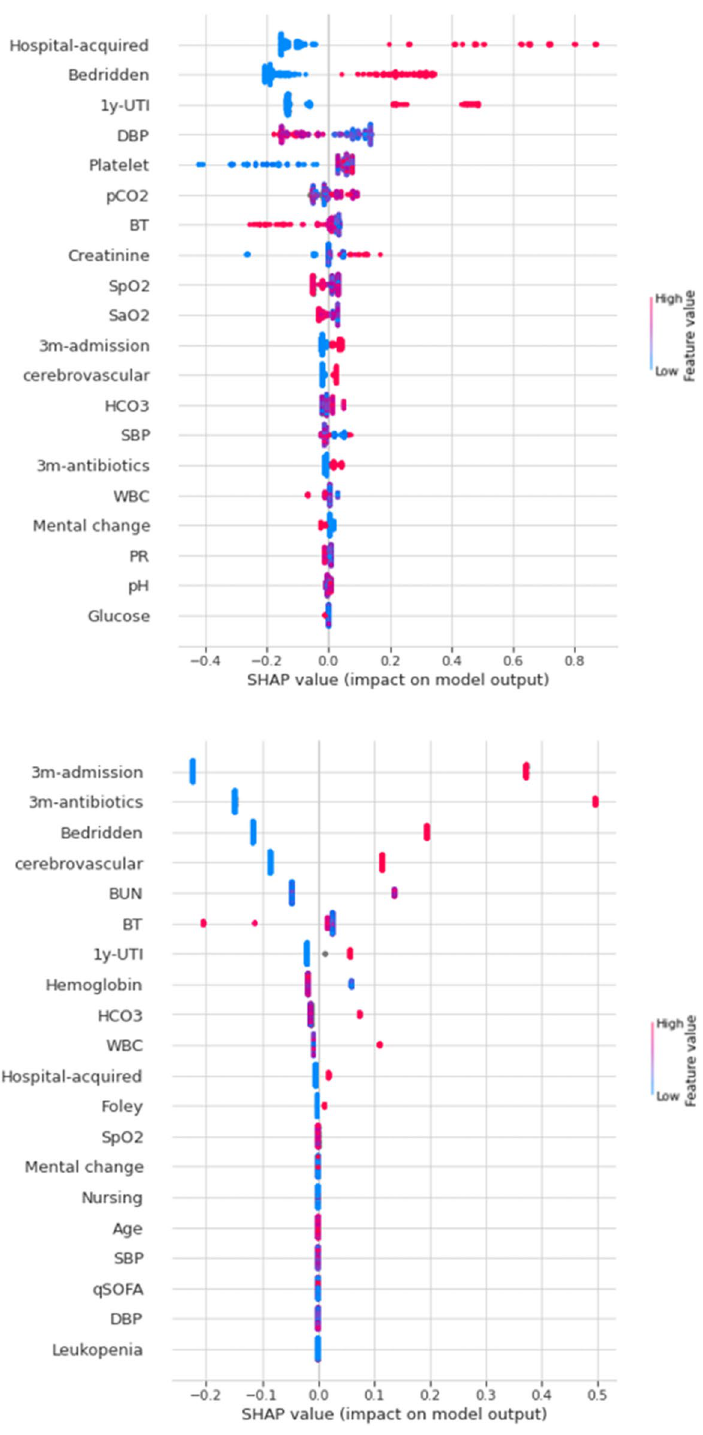
Figure 5. Feature importance for ciprofloxacin resistance (top) and positivity of extended-spectrum beta- lactamases (bottom) using Shapely Additive exPlanations (SHAP). The top 20 variables were visualized among 39 variables. 1y-UTI, UTI within a year; DBP, diastolic blood pressure; BT, body temperature; SpO2, peripheral oxygen saturation; SaO2, arterial oxygen saturation; 3m-admission, hospitalization within 3 months; SBP, systolic blood pressure; 3m-antibiotics, antibiotics use within 3 months; WBC, leukocyte count; PR, pulse